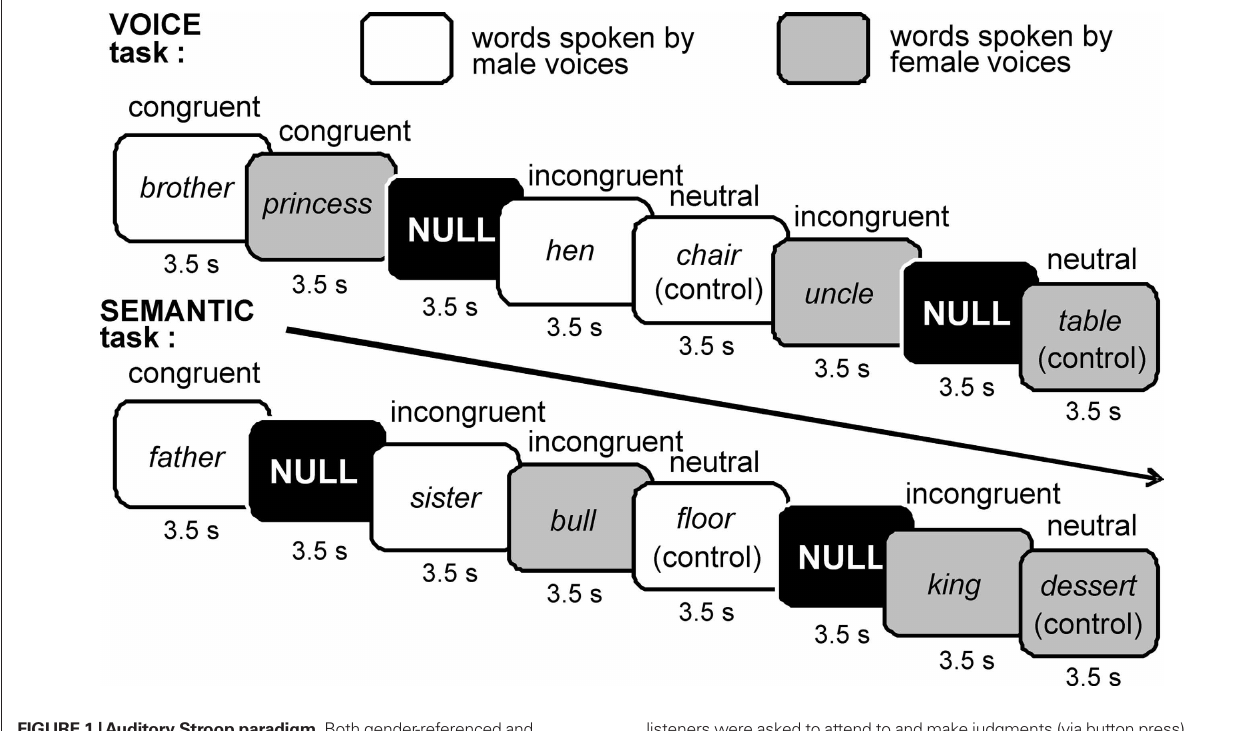
FIguRe 1 | Auditory Stroop paradigm. Both gender-referenced and gender-neutral nouns were recorded by men and women. These words were presented one per trial through MRI-compatible headphones using a sparse scanning protocol (see Materials and Methods). In the VOICE task,